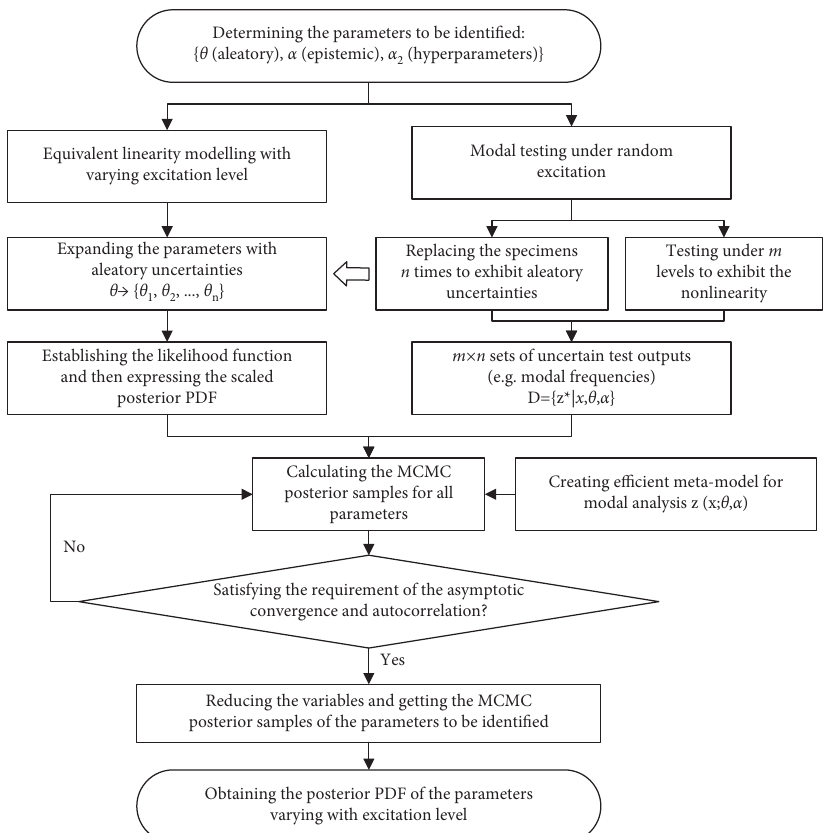
Figure 3: The flowchart of the VEB identification